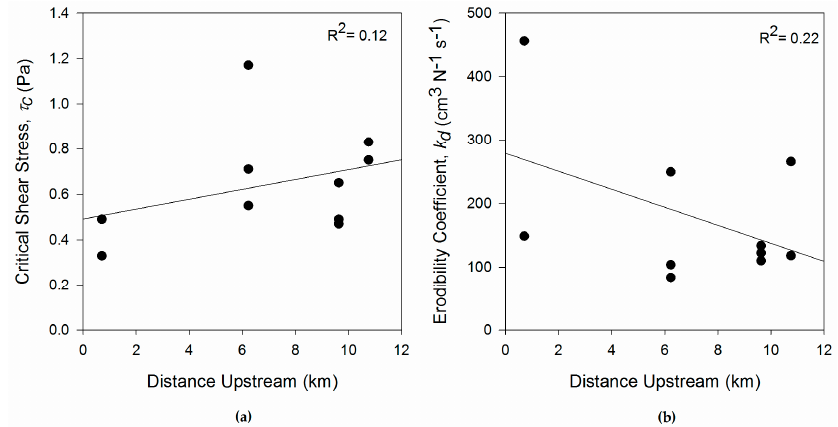
Figure 5. Regression for excess shear stress model parameters determined using JETs versus distance upstream for Fivemile Creek (FC-FM): ( a ) τ c : and ( b ) k d .